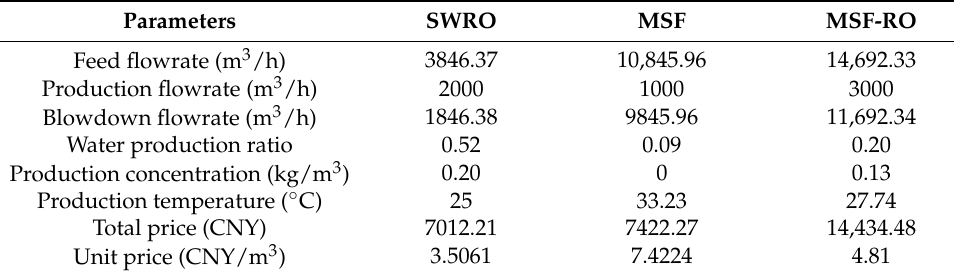
Table 7. Overall water production in option